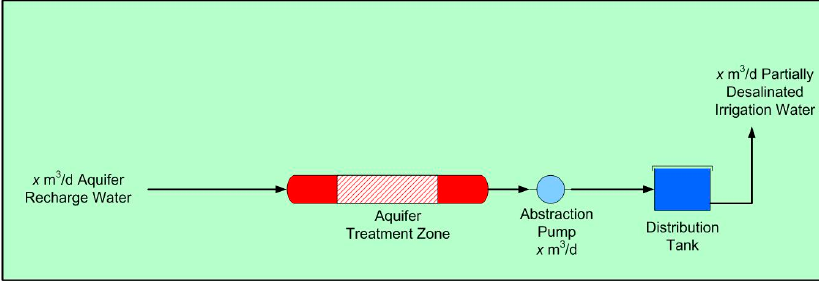
Figure 18. Process flow diagram for a schematic aquifer, which has been reconstructed as a Static Aquifer Treatment Zone.